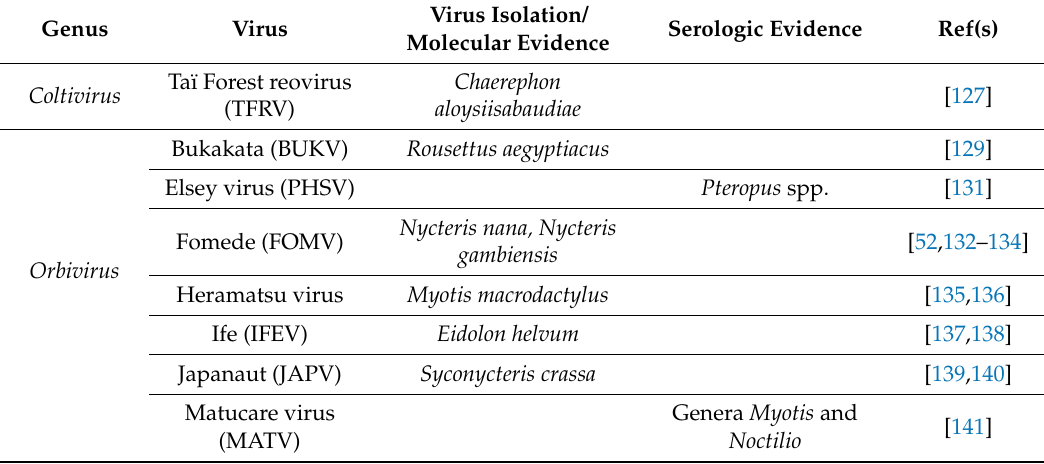
Table 3. Table describing species with published results describing virus isolation, molecular evidence, or seroconversion to species in Family Reoviridae